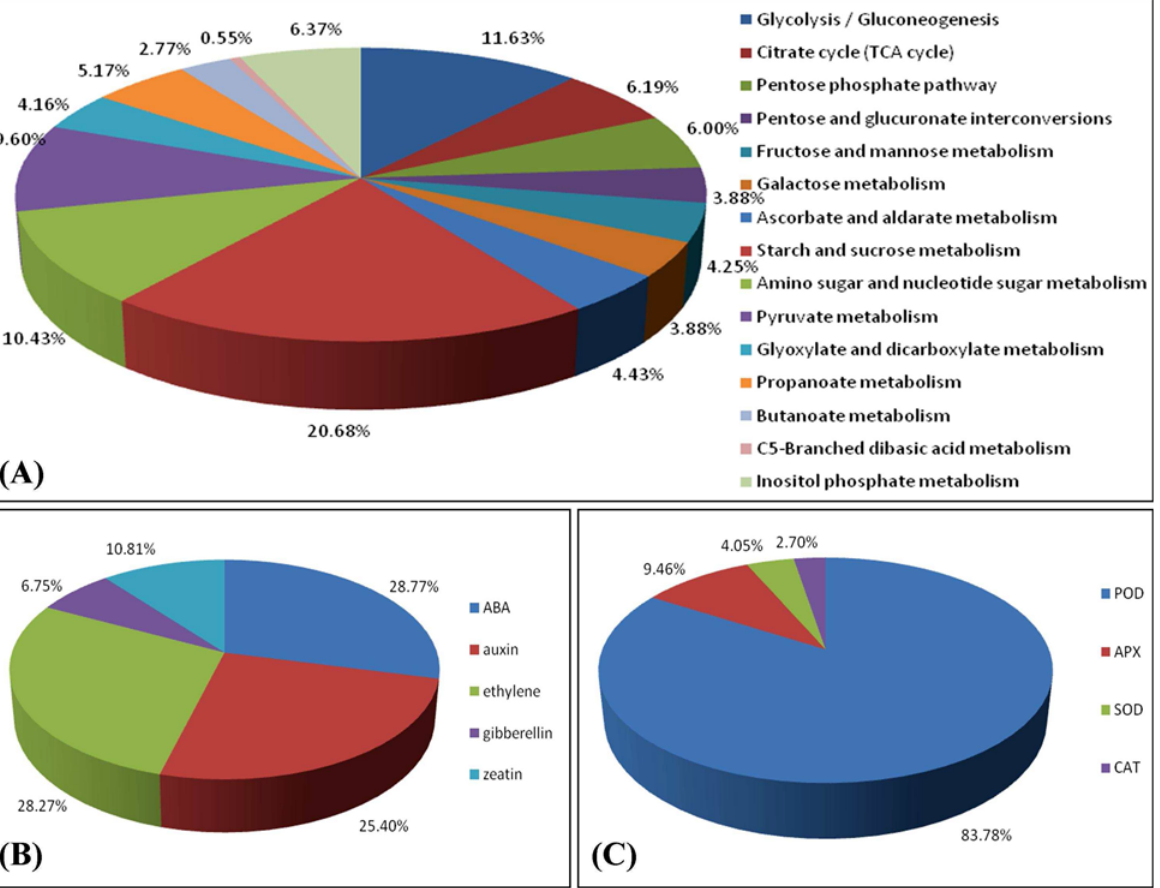
Fig 7. The proportions of sequences related to carbohydrate metabolism, plant hormones and antioxidant enzymes. (A) The proportion of sequences related to carbohydrate metabolism. (B) The proportion of sequences related to five internal plant hormones. (C) The proportion of sequences related to four antioxidant enzymes.